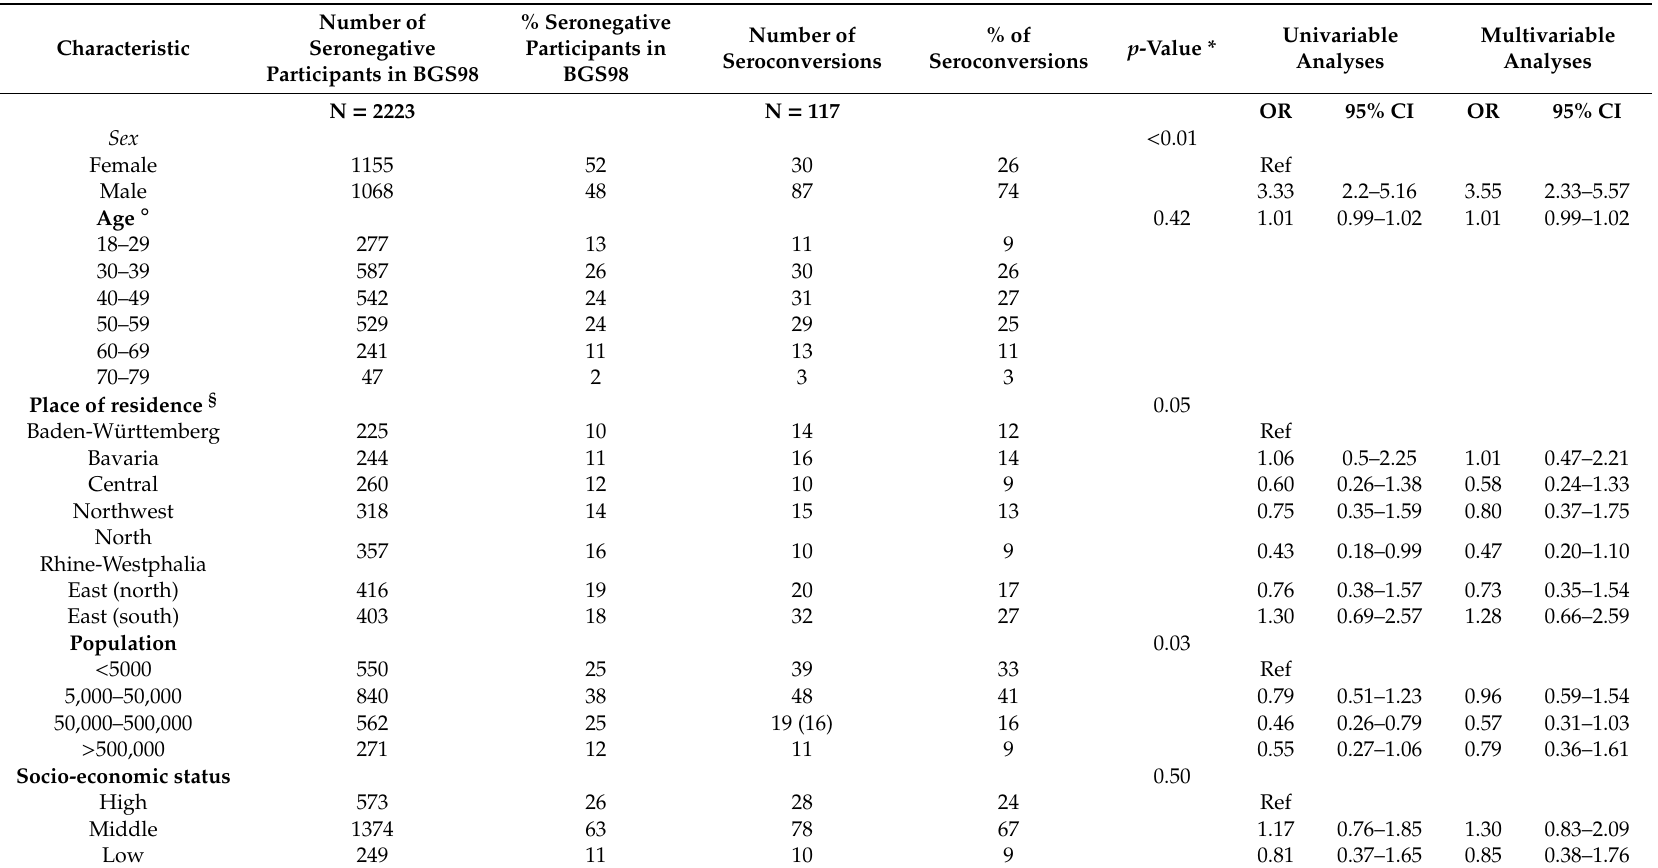
Table 1. Predictors of seroconversion of Borrelia burgdorferi -specific antibodies among participants of two population-based serosurveys in Germany, 1997–1999, and 2008–2011 (n =